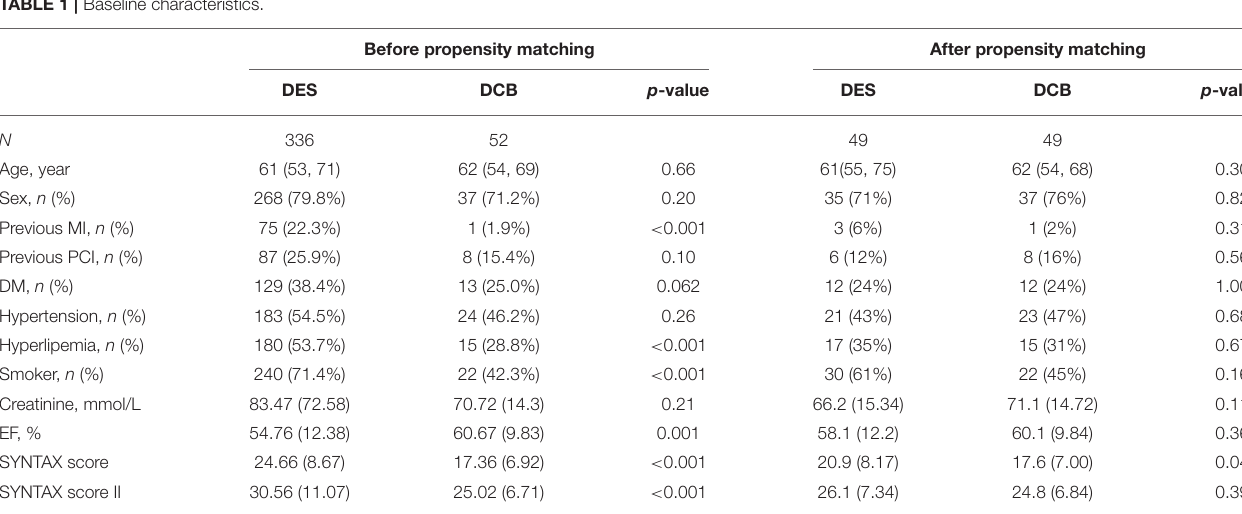
TABLE 1 | Baseline